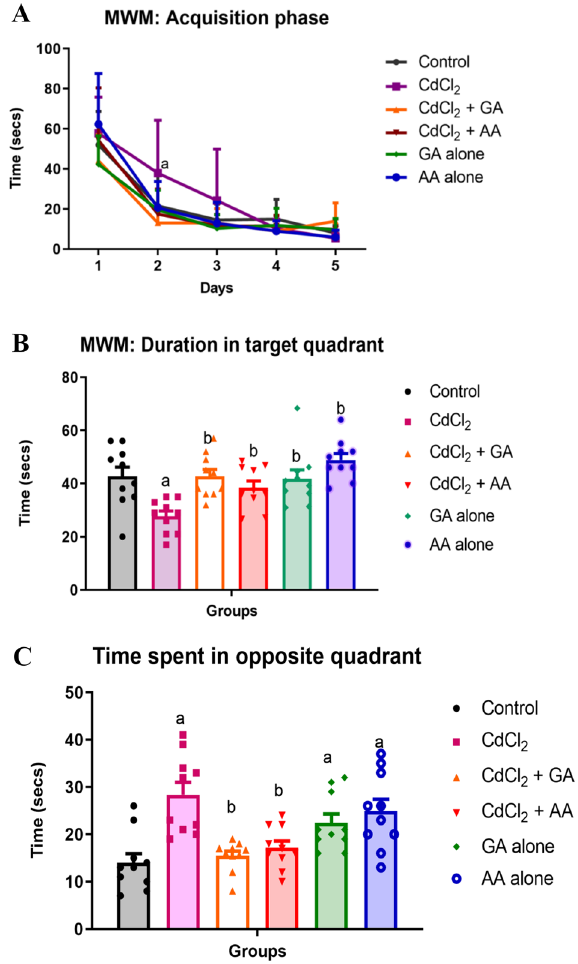
Figure 3. ( A ) Learning curve during the acquisition phase of the Morris water maze test ( B ) The probe trial of the Morris water maze showing time spent in the target quadrant and ( C ) The time spent in the opposite quadrant. Values are presented as mean ± Standard Deviation n = 12/group; a indicates significant difference at p < 0.05 compared with control; b Indicates significant difference at p < 0.05 compared with CdCl 2 (one-way ANOVA; n = 12). GA gallic acid, AA ascorbic acid.